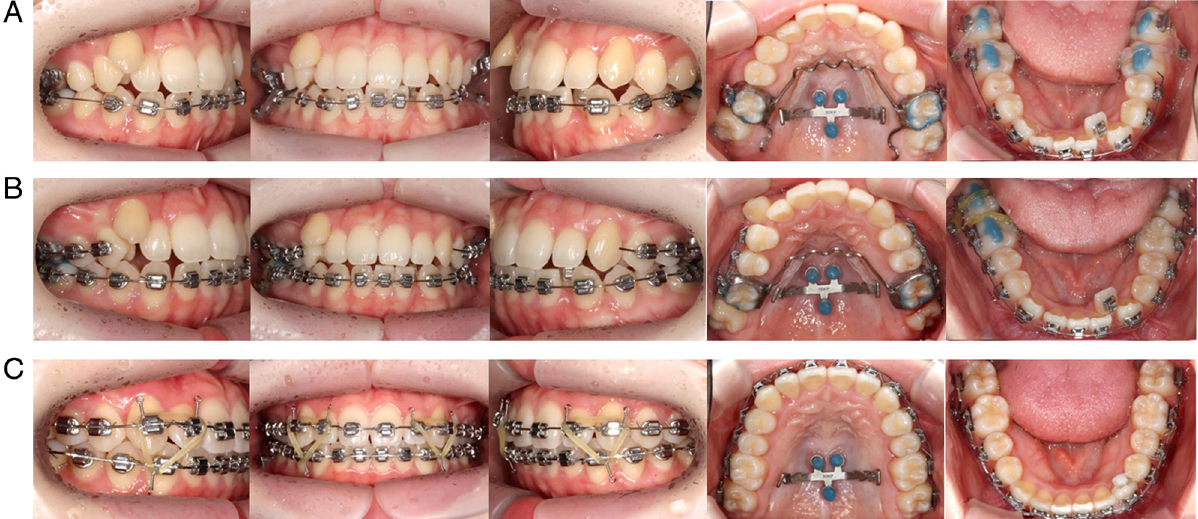
Figure 3. Treatment progress intraoral photographs and cone-beam computed tomographic images. (A, B) Three-dimensional key plate (3DKP) with transpalatal WAVE wire and extension arms for distalisation and palatal uprighting of the maxillary molars, fixed orthodontic appliance for levelling of the mandibular dentition, and miniscrews in the buccal shelf for distalisation, buccal uprighting and intrusion of the mandibular molars. (C) Finishing.